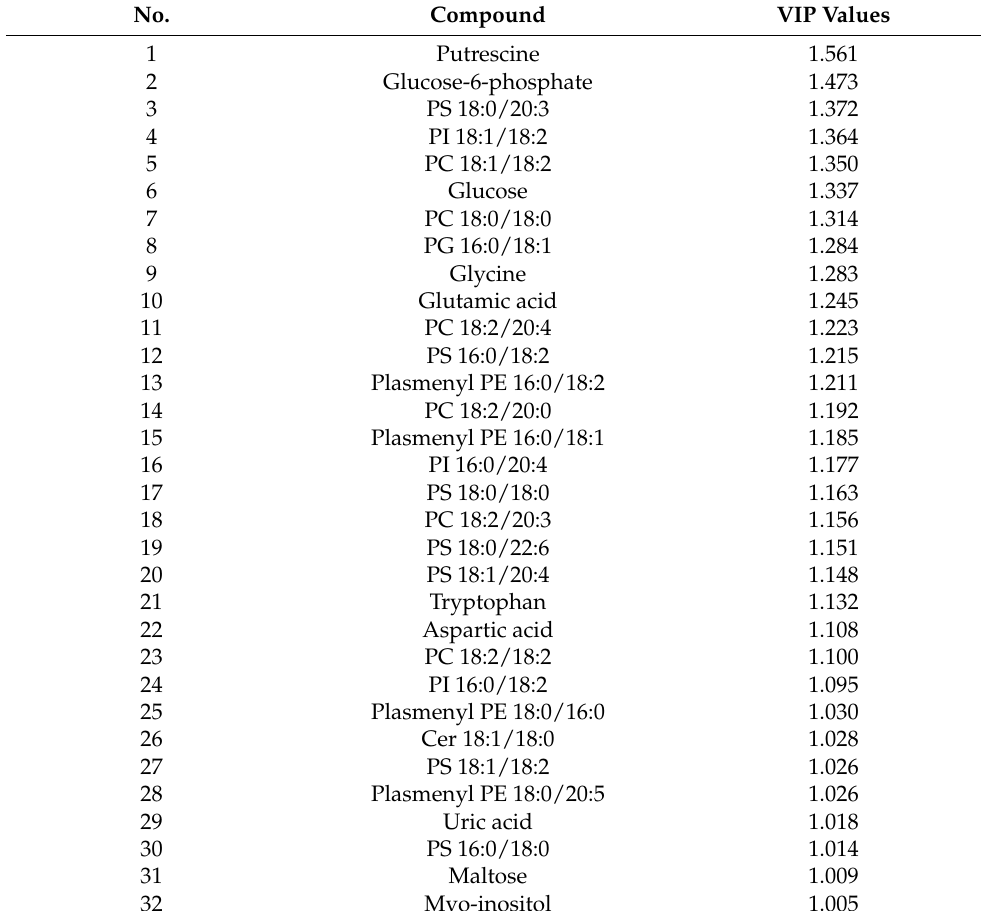
Table 1. Metabolites and lipids identified with variable influence on projection (VIP) values greater than